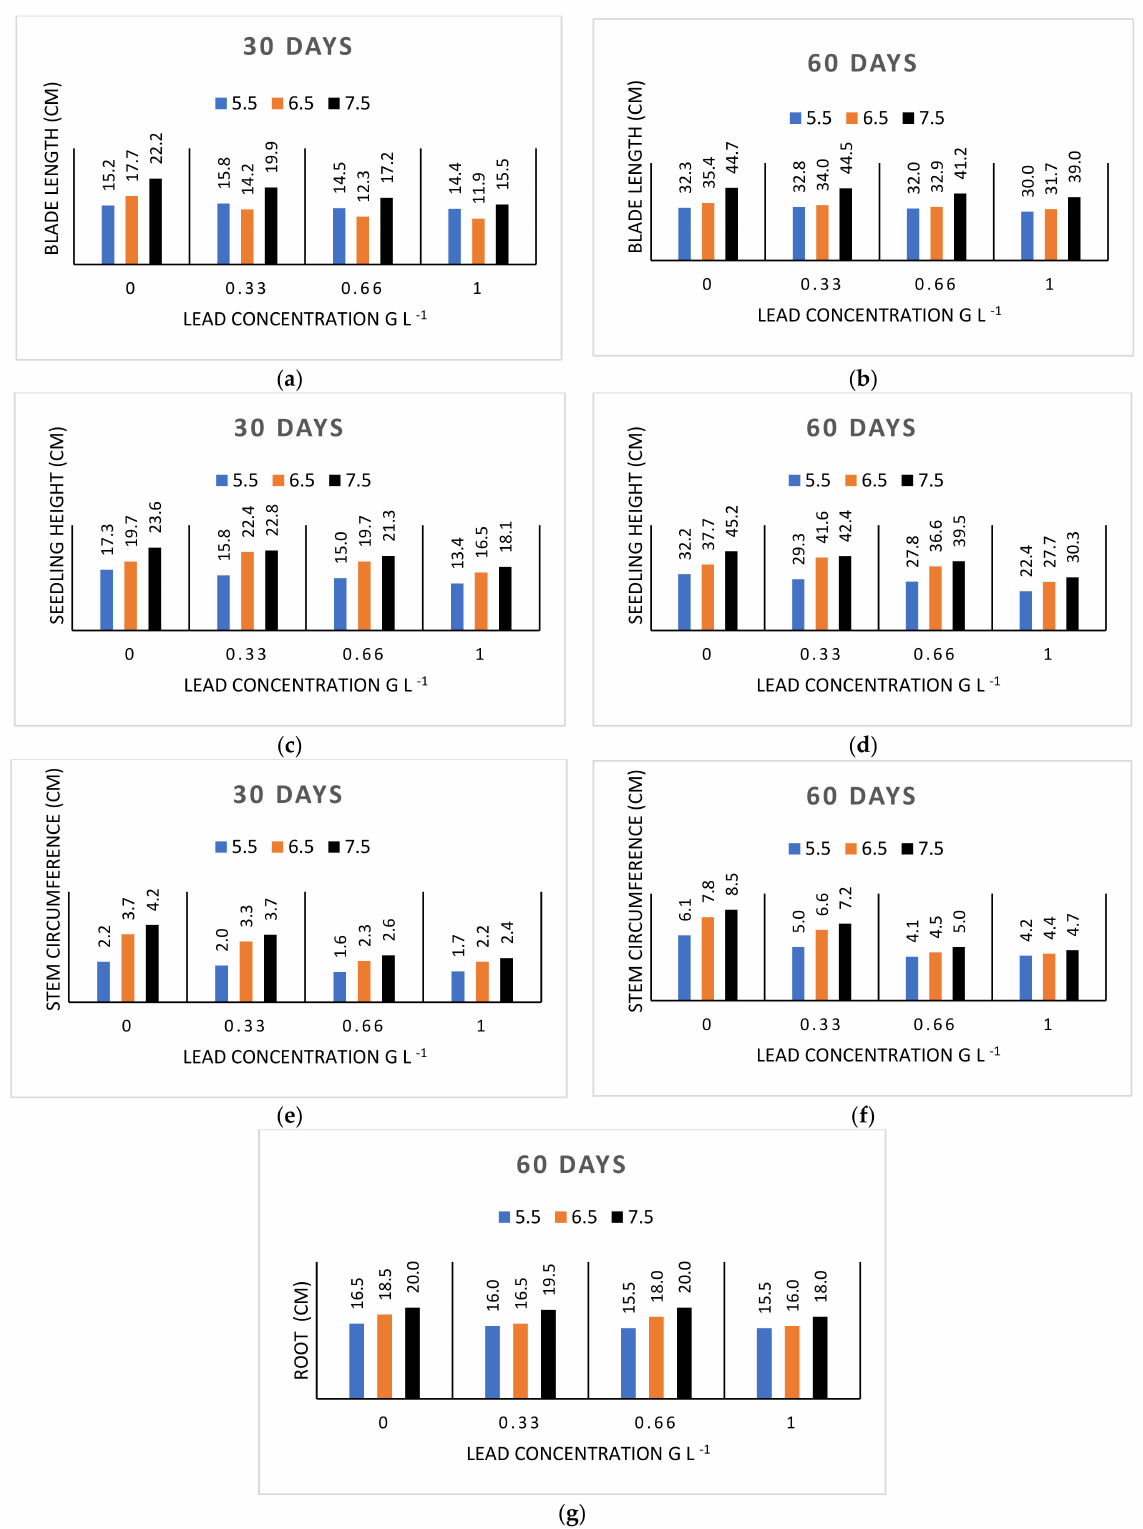
Figure 6. Average results of the seedling leaves in centimeters. Leaf length: ( a ) after 30 days, ( b ) after 60 days. Seedling height: ( c ) after 30 days, ( d ) after 60 days. Stem circumference measured at the base of the seedling: ( e ) after 30 days, ( f ) after 60 days. Main root: ( g ) after 60 days. pH levels: 5.5, 6.5,